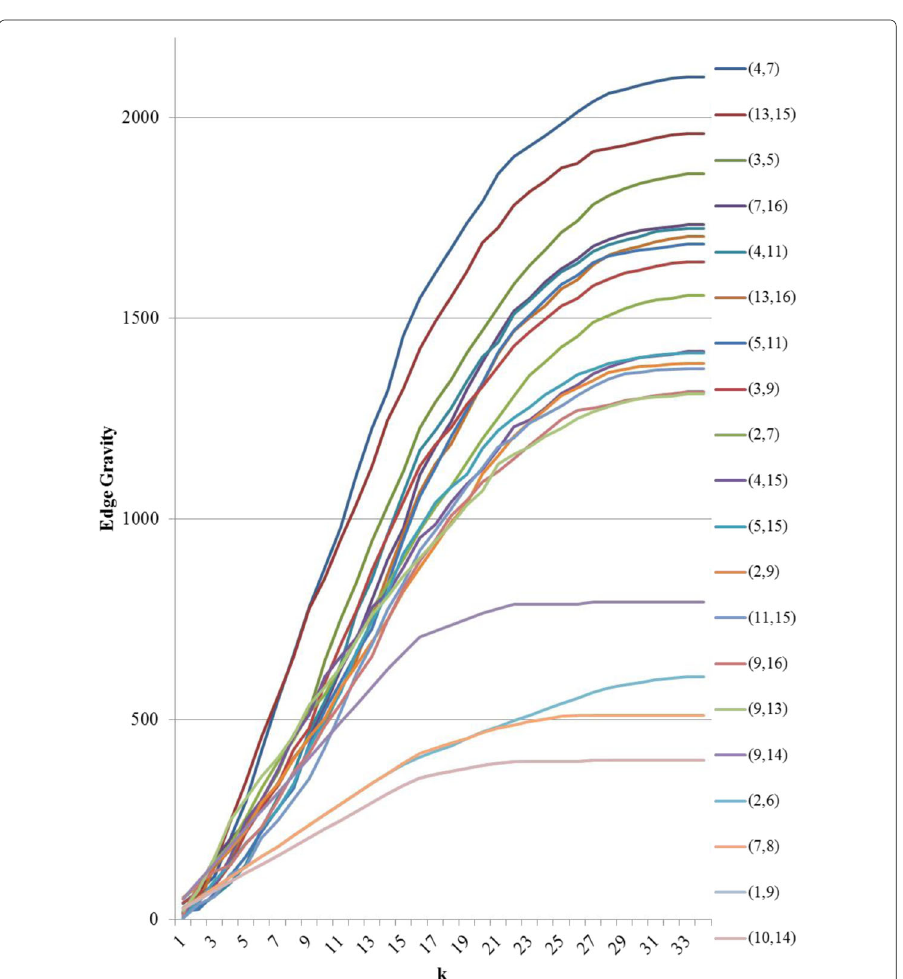
Fig. 15 Edge Gravity solutions for the Florentine families network when solving successively for k = 1,2,3, ... ,33